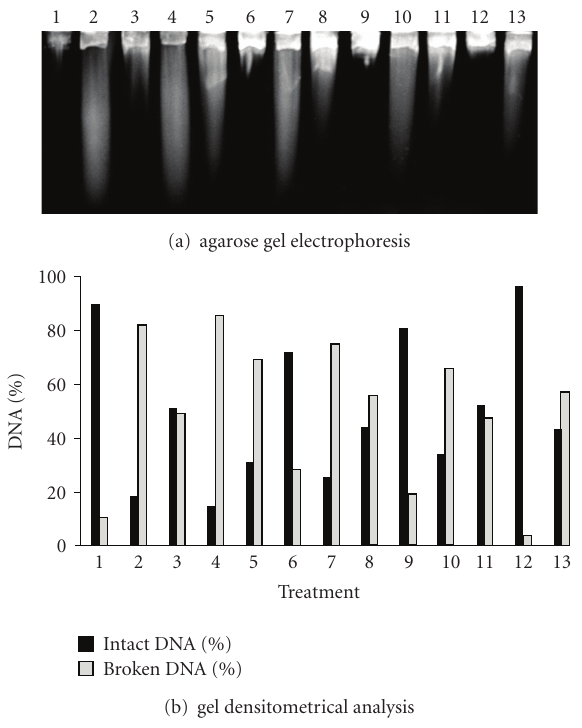
Figure 5: Alkaline gel electrophoresis of E. coli AB1157 treated with SnCl 2 (25 μ g/mL), UVA (90kJ/m 2 ) and pre-illuminated with UVA, followed by SnCl 2 incubation. Lanes: (1) control; (2) SnCl 2 ; (3) UVA; (4) UVA + SnCl 2 ; (5) SnCl 2 30 minutes; (6) UVA 30 minutes; (7) UVA + SnCl 2 30 minutes; (8) SnCl 2 60 minutes; (9) UVA 60 minutes; (10) UVA + SnCl 2 60 minutes; (11) SnCl 2 90 minutes; (12) UVA 90 minutes; (13) UVA + SnCl 2 90 minutes.